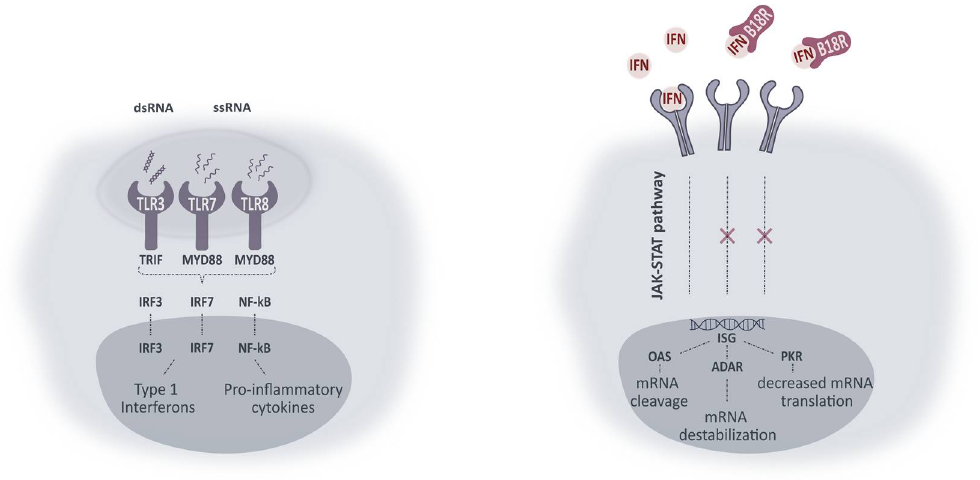
Figure 8. Simplified representation of intracellular pathways activated upon TLR activation and working mechanism of B18R. Activation of TLRs leads to interaction with adaptor molecules TRIF and MYD88. Initiation of successive pathways results in activated transcriptions factors (IRF3, IRF7 and NF-κB) causing production of type 1 IFNs and pro-inflammatory cytokines. Type 1 IFNs in their turn can activate IFN receptors in an autocrine or paracrine fashion. Activation of IFN receptors leads to the production of IFN-stimulated genes (ISG) via the JAK-STAT pathway. ISG can lead to production of proteins included in the signaling pathways (not shown) or proteins inducing mRNA damage or diminished mRNA translation. ssRNA, single-stranded RNA; ds RNA, double-stranded RNA; TLR, Toll-like receptor; TRIF, Toll-IL-1 receptor domain-containing adapter protein inducing IFN-β; MYD88, myeloid differentiation primary response protein 88; IRF, interferon regulatory factor; NF-kB, nuclear factor- κ B; IFN, type 1 interferon; JAK-STAT, Janus kinase 1- Signal transducer activator of transcription; ISG, IFN-stimulated genes; OAS, 2’-5’-oligoadenylate synthetase; ADAR, RNA-specific adenosine deaminase; PKR, dsRNA dependent protein kinase.